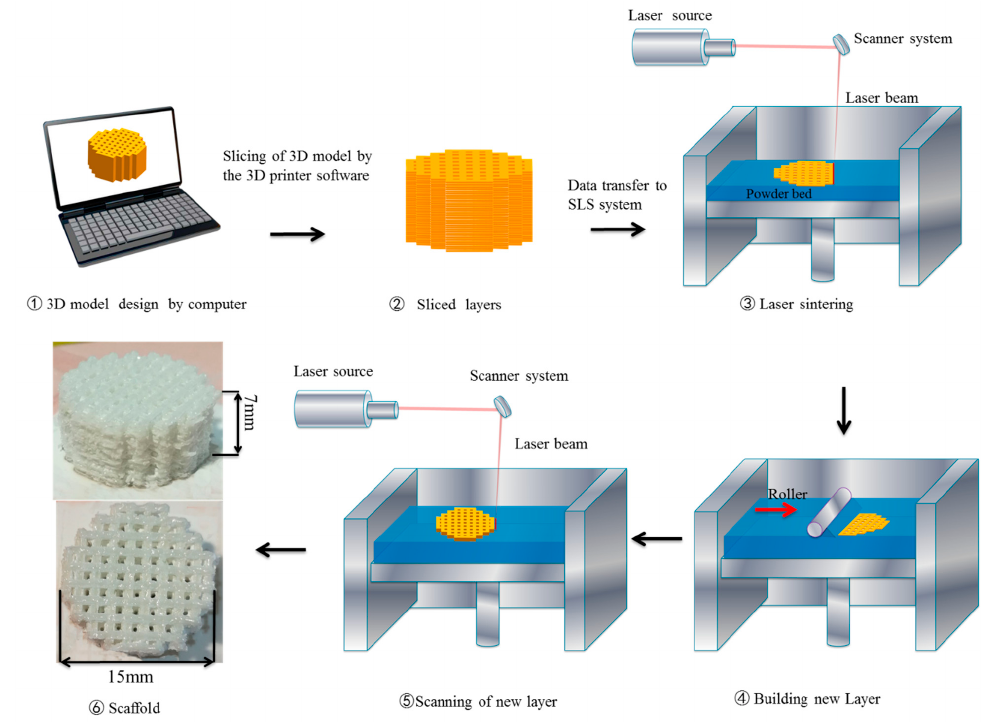
Figure 1. Simplified schematic of the selective laser sintering (SLS) process.